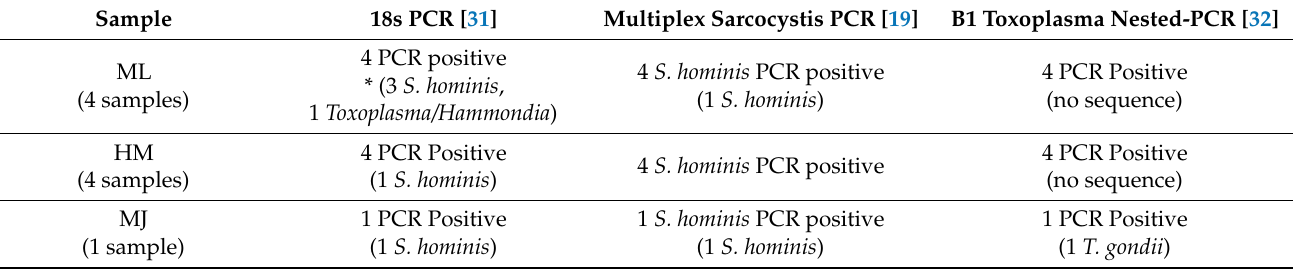
Table 2. Results of PCR and Sequencing on tested